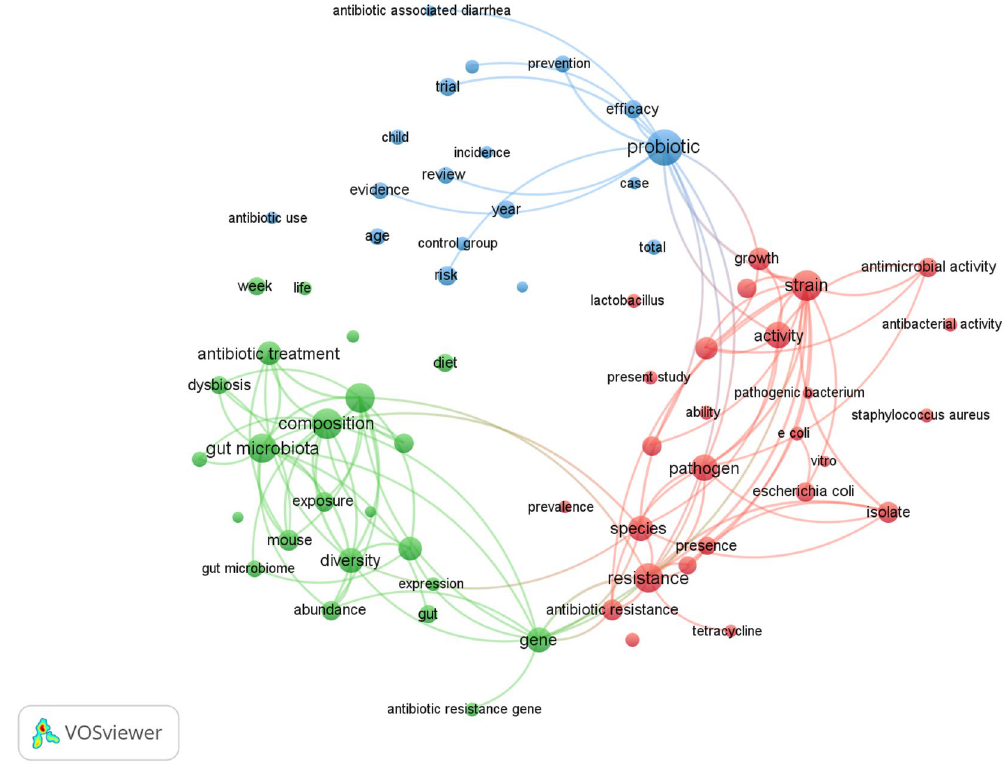
Figure 3. Research topics clustered by mapping the cooccurrences of terms for publications on microbiota and antibiotics. Of the 49,251 terms, 111 terms occurred at least 100